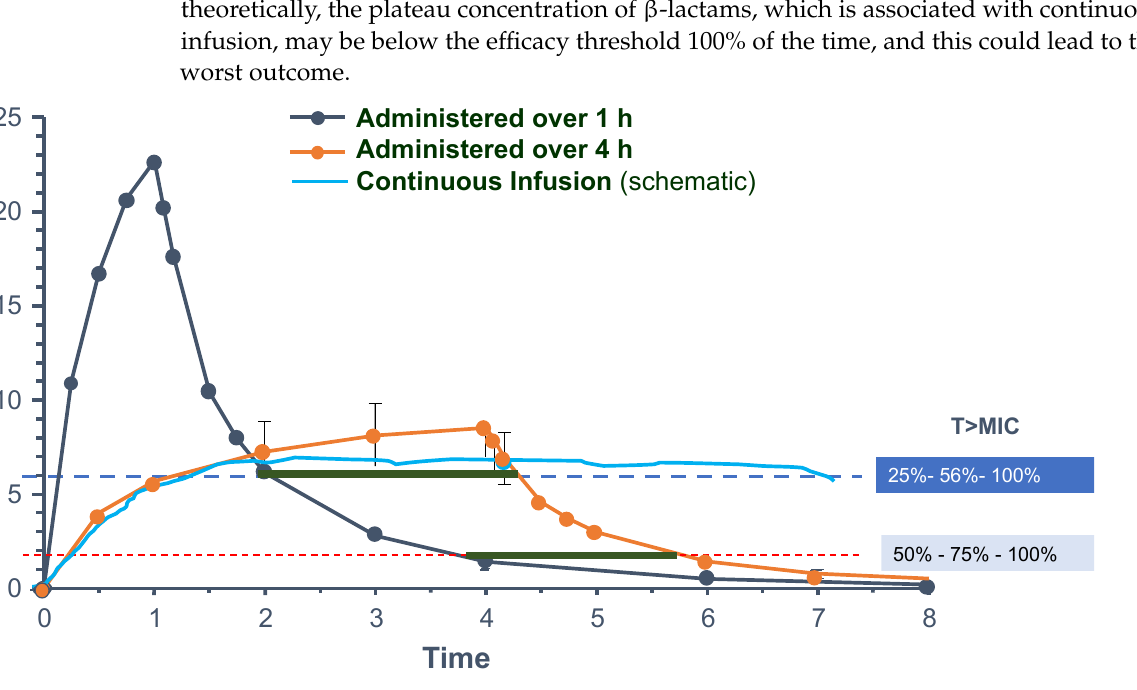
Figure 2. Concentration–time curves of β -lactams according to administration times of 1 or 4 h and a schematic representation of continuous infusion. Conventional 1 h bolus dosing achieved high peak concentrations, while prolonged or continuous infusions had more stable, albeit lower, concentrations. However, these also had increased time above the minimal inhibitory concentration and faster killing kinetics. This could be especially important when bacteria are less sensitive to the antibiotic (adapted from [57]).